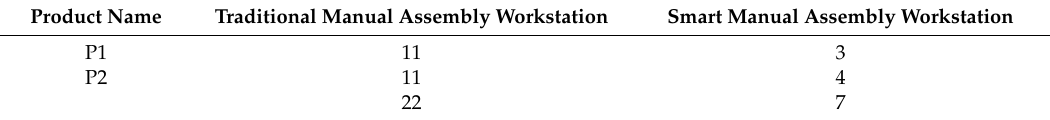
Table 2. The number of errors occurred at traditional and smart manual assembly workstation.